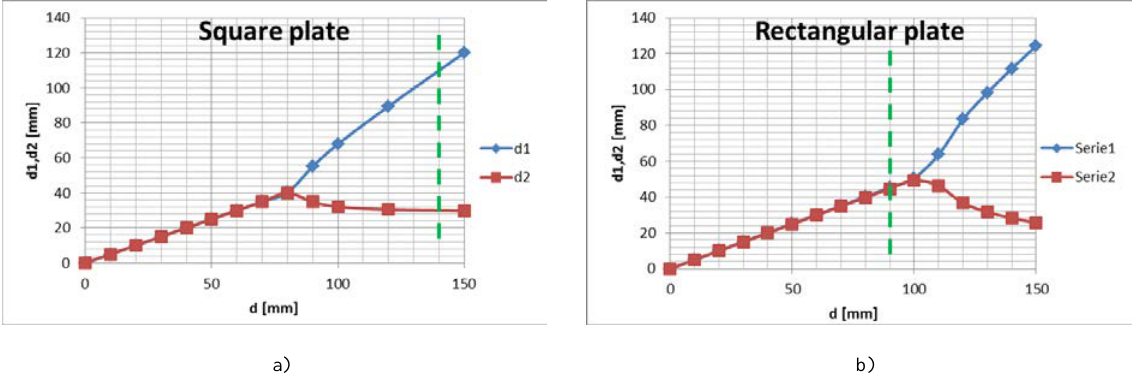
Fig. 4 Four- point supported glass plate. Displacements δ 1 and δ 2 as functions of the prescribed total displacement δ. a) 2 m × 2 m and b) 2 m × 1 m glass plate, 10 mm thick. To investigate the influence of geometric parameters on the arising of the instability, the case of four-point supported rectangular plates of size a × b , made of monolithic glass of thickness h , is here considered here. Fig. 5a and Fig. 5b shows the buckling limit for a monolithic glass plate, 8 mm and 12 mm thick, respectively, as a function of the plate edge lengths a , b =1 ÷3 m. Graphs have been obtained by means of a numerical parametric analysis performed with Abaqus, accounting for geometric nonlinearities. Again, the numerical analyses have been performed using a 3-D structured mesh with C3D20R elements.